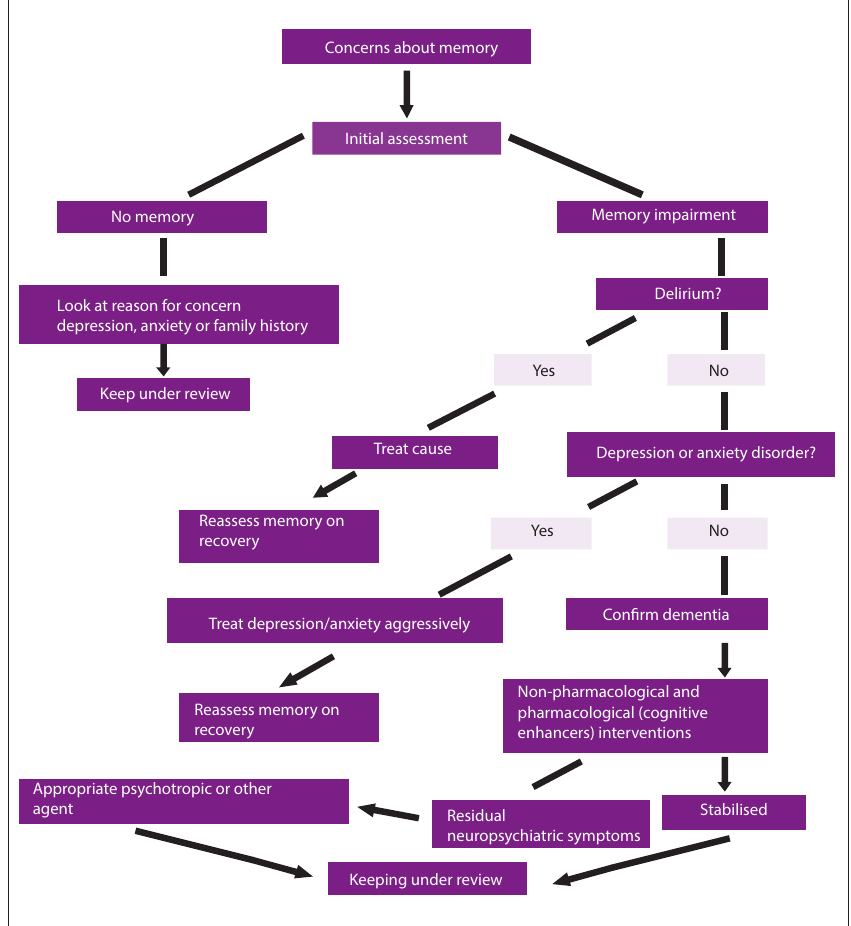
Fig. 3. Algorithm for therapy of dementia (adapted from Daoud [55]